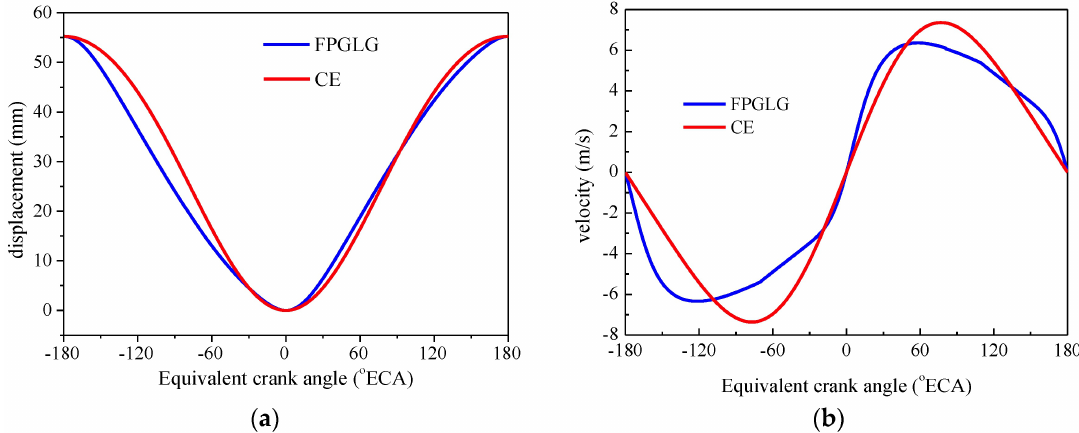
Figure 4. Plot of free piston engine displacement (blue) and velocity versus conventional engine (red) for one piston cycle [47].